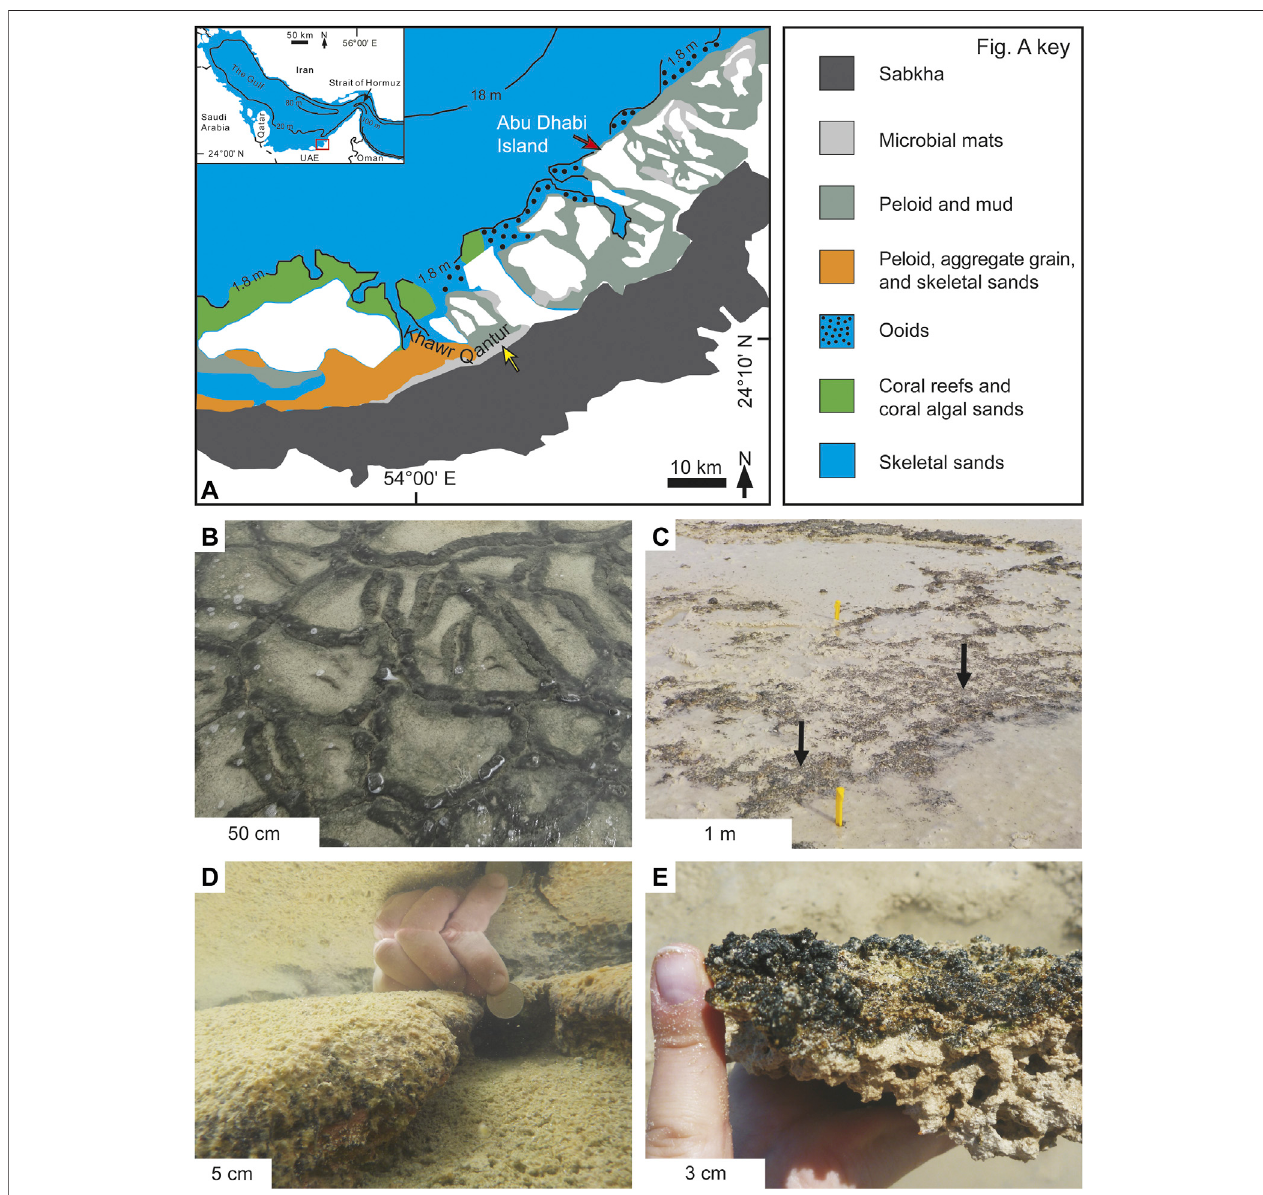
FIGURE 1 | Geological and sedimentary background of microbial mats at Abu Dhabi, UAE (A) Holocene bathymetric and sediment distribution of Abu Dhabi coastalarea(modi fi edafterKendalletal.,1994),andthestudylocationindicatedbytheyellowarrow (B) Thelandwardpartofthemicrobialmatsshowingwell-developed polygons and larger thickness (up to 20 cm) (C) The seaward part of the microbial mats showing patchy distribution (black arrows), lateral discontinuity and smaller thickness (0.eight to six cm) (D) Stromatolites in the tidal creeks in the microbial mats (E) Firmground in the microbial mats with downward-decreasing degree of